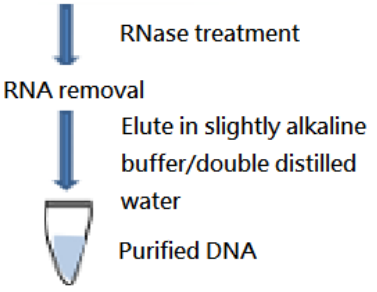
Figure 1. Basic steps involved in all DNA extraction methods.